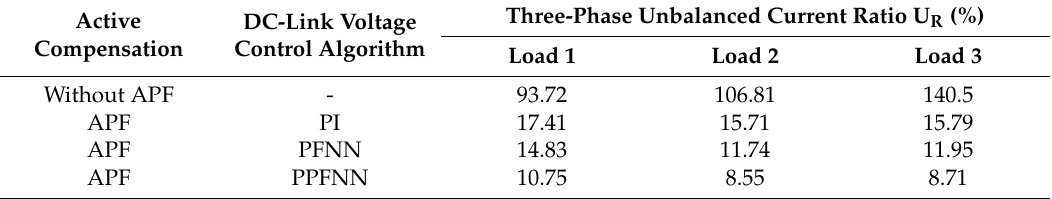
Table 1. Three-phase unbalanced current ratio using different controllers.